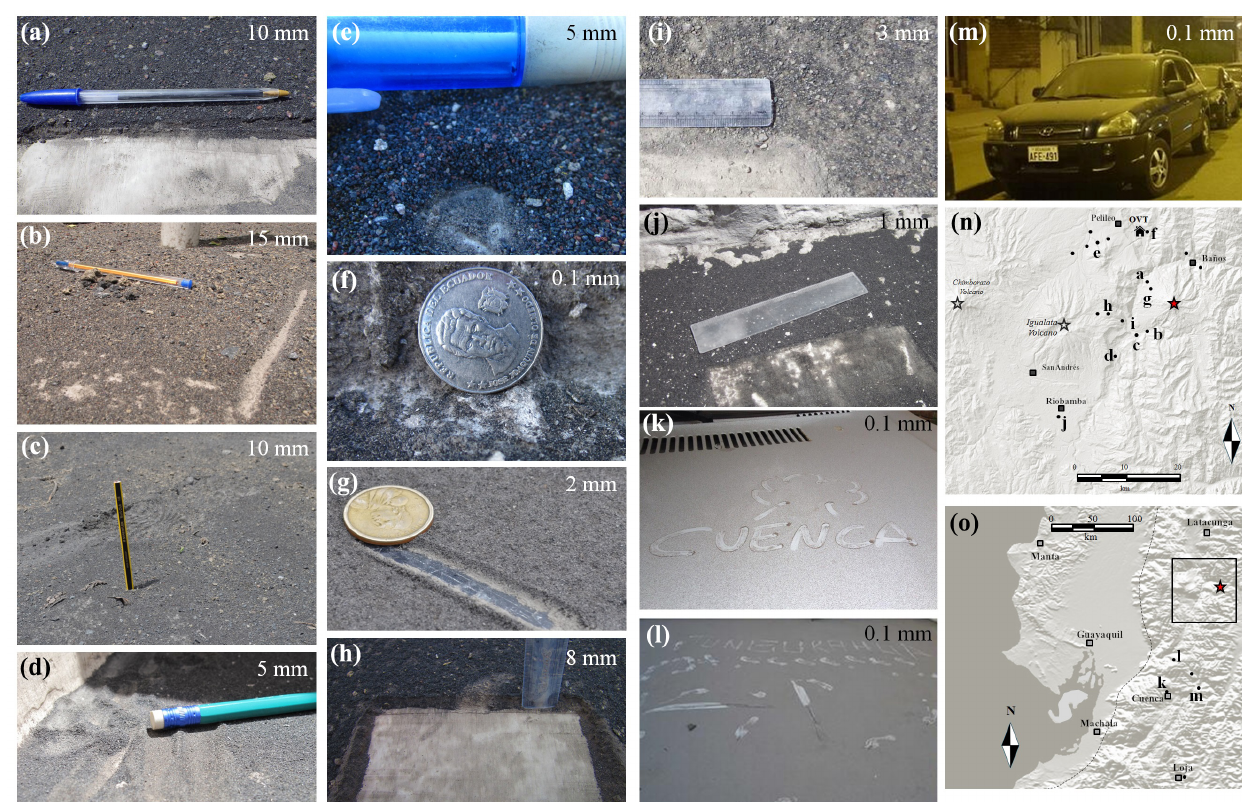
Figure A1. Field observations of the February 2014 tephra fall deposits at proximal (a–i) , medial (j) and distal areas (k–m) . Distal points were all observed on 1 February, while proximal to medial observations were taken before 14 February. The location of points is reported in the adjunct maps. Labels for point locations are (a) San Juan, (b) Palictahua 1, (c) Palictahua 2 (Ganzhi), (d) Capil, (e) Humbalo, (f)